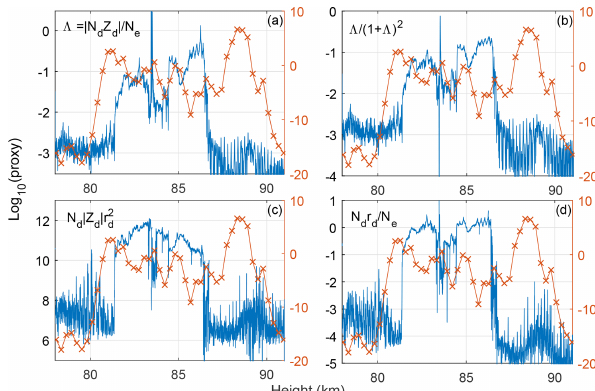
Figure 16. Comparison of proxies from dusty plasma parameters to PMSE SNR for the MXD-1 flight. Panels (a) and (b) show proxies based on the ratio of dust charge number density to electron density. The proxy in (c) can be recognized as the parameter utilized by Rapp et al. (2003b), while (d) is the P factor introduced in Havnes (2004) as an ordering parameter in dust cloud modelling.